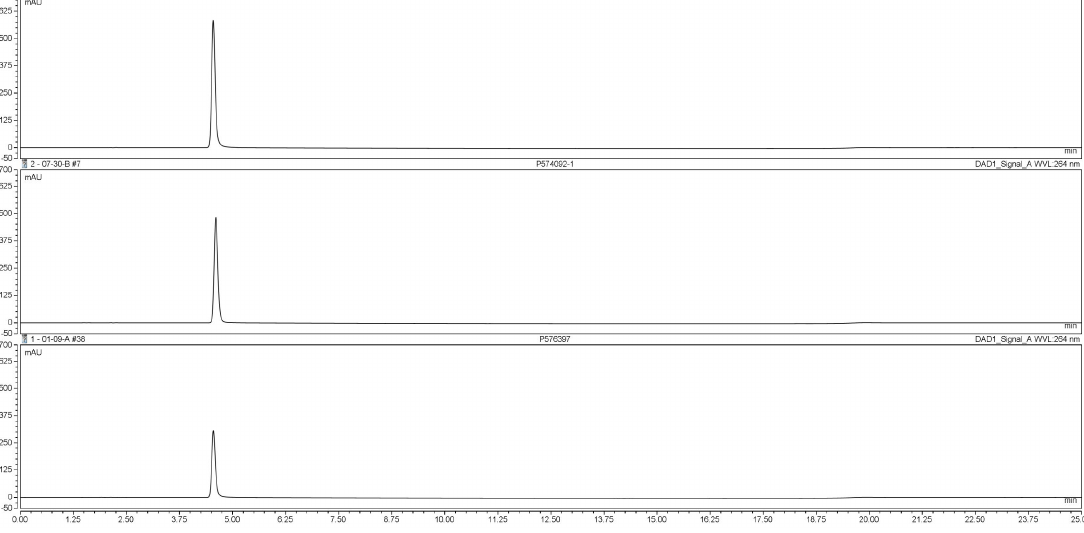
Figure 3. HPLC chromatograms of niacinamide reference solution ( top ), sample solution from quality control ( middle ) and sample solution from used wipe ( bottom